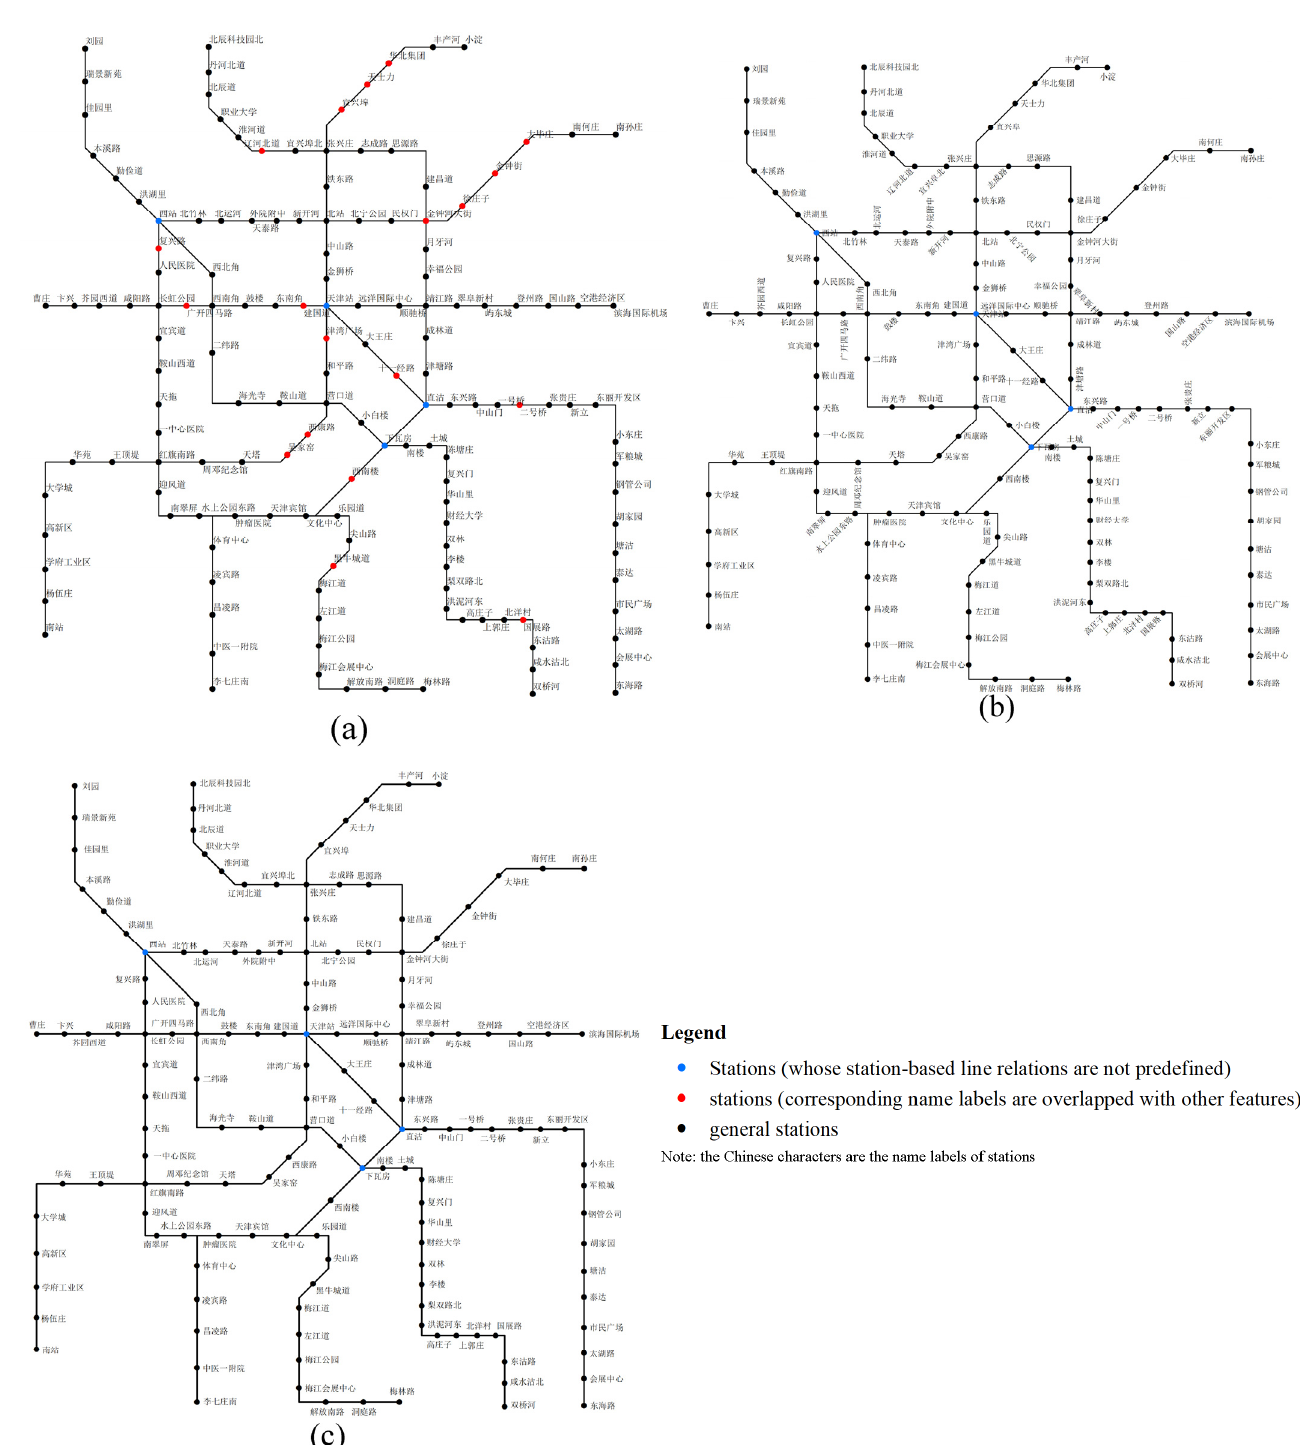
Figure 11. Name labels of Beijing metro networks placed by: ( a ) maplex; ( b ) descriptive-statistics- based method; and ( c ) ANNs.